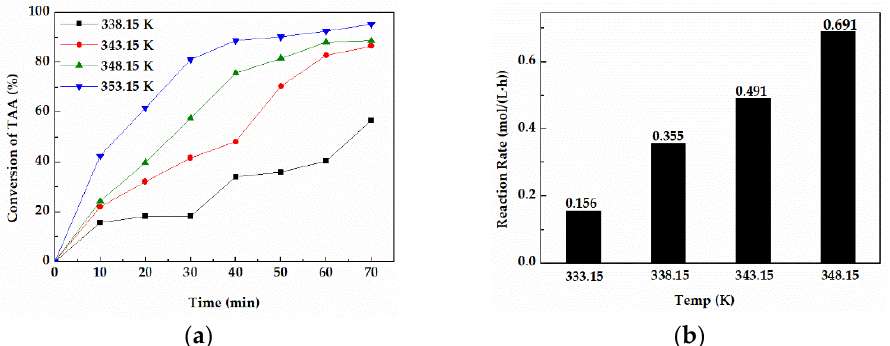
Figure 3. ( a ) Conversions of TAA at different temperatures for 70 min. ( b ) The average reaction rate in 30 min at different temperatures.